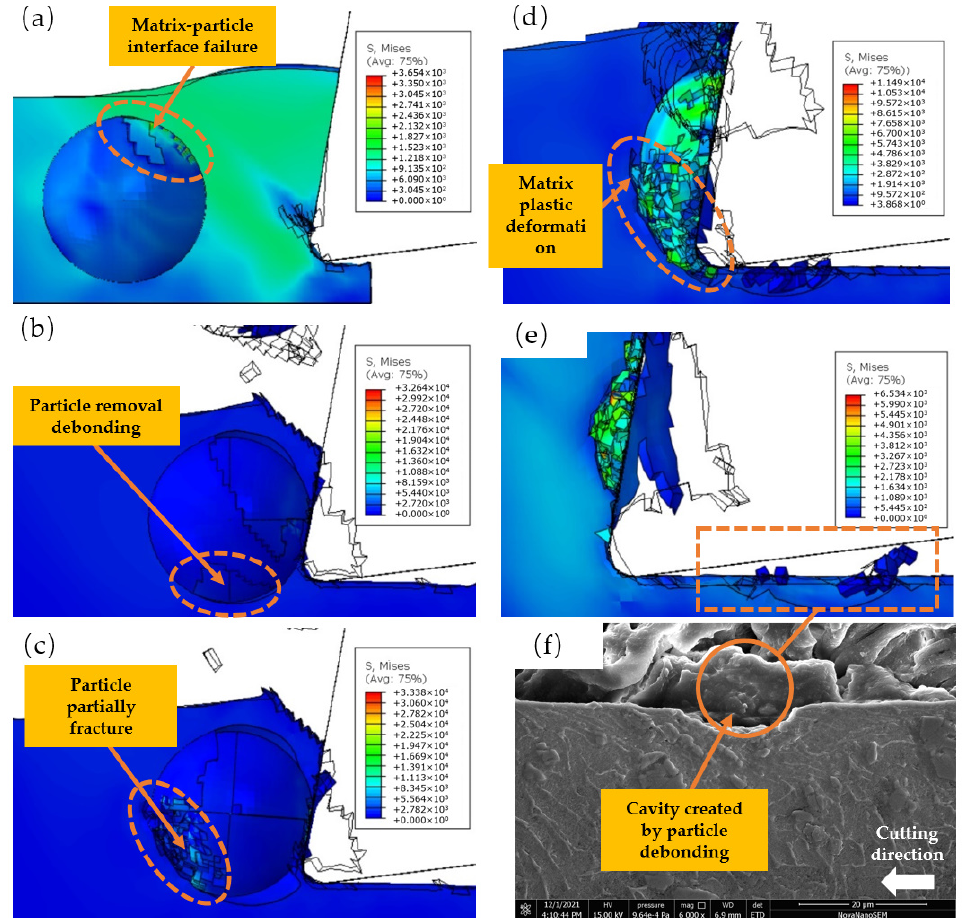
Figure 10. Simulation of cutting process of particles above cutting path: ( a ) matrix-particle interface failure above TiC particles; ( b ) TiC particles that are in contact with the tool; ( c ) TiC particle cleavage under tool extrusion; ( d ) TC4 matrix scratched by TiC particles; ( e ) simulation results of cavity generated by particle debonding; and ( f ) test results of the cavity produced by particle debonding.